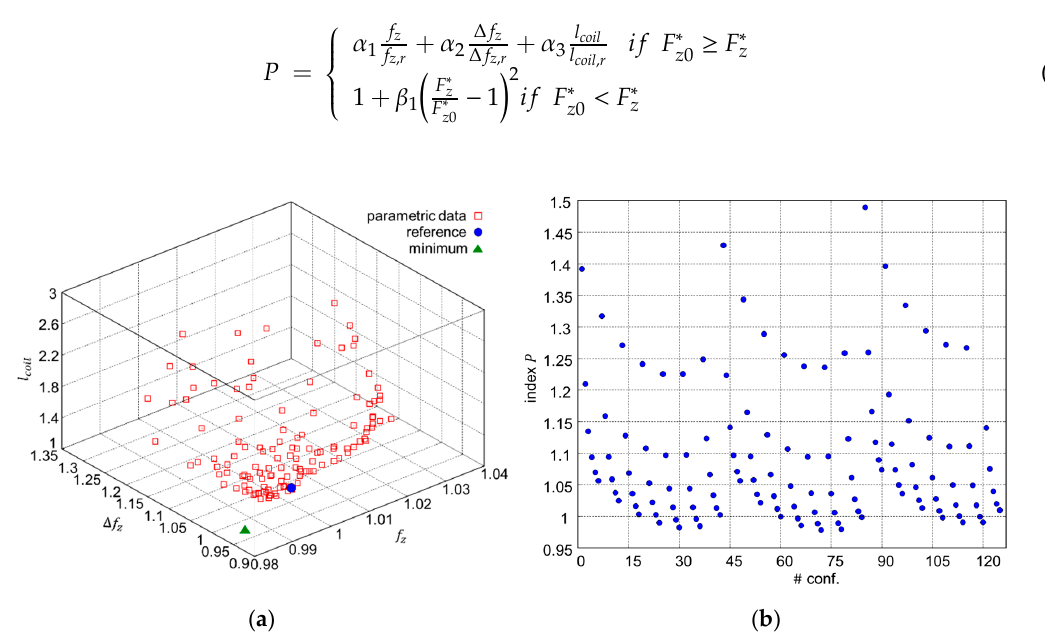
Figure 8. Results of the parametric analyses; ( a ) per unit (p.u.) quantities; ( b ) performance index.